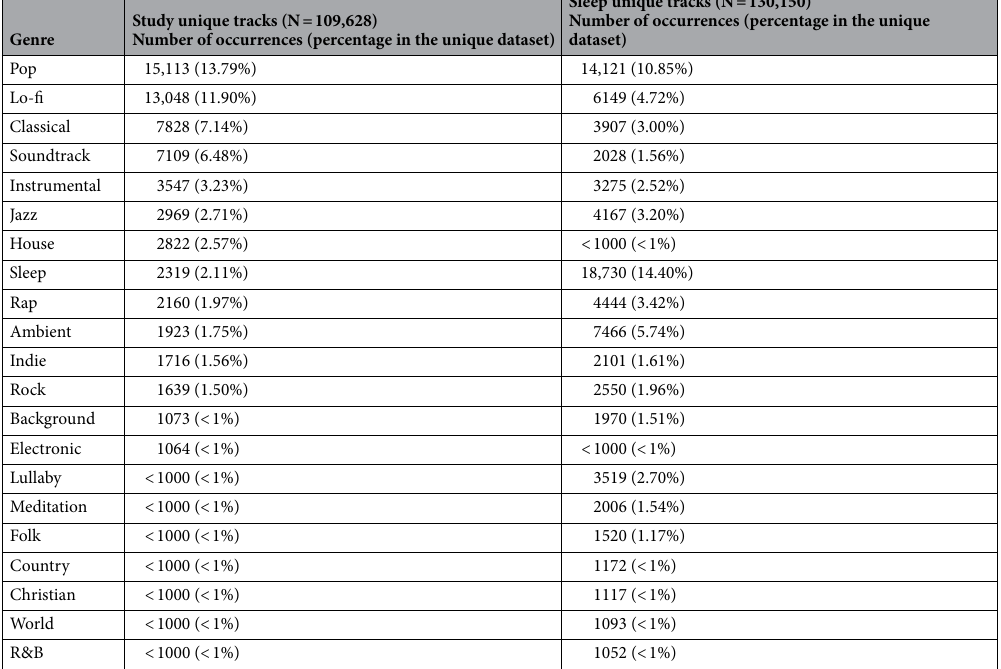
Table 3. Genres that appear more than 1000 times in either the unique Sleep music dataset or that appeared more than 1000 times in the unique Study music dataset sorted in descending order according to their prevalence in the Study dataset. Many tracks of each dataset, 10,792 tracks of Study music (9.4%) and 11,624 (8.9%) tracks of Sleep music, were unable to be categorised due to their obscure genre labels. Furthermore, there were 782 uncategorized genres in the Study dataset and 789 in the Sleep dataset. These genres, such as ‘otacore’ or ‘dangdut’, were not able to be matched to any of the genre categories defined in Table 2. There were relatively few of each of these genres, with the most prevalent Study uncategorised genre being ‘chillhop’ with 722 occurrences and ‘drift’ as the most prevalent uncategorised Sleep genre with 545 occurrences, meaning that their inclusion as a new genre would not have altered this table.